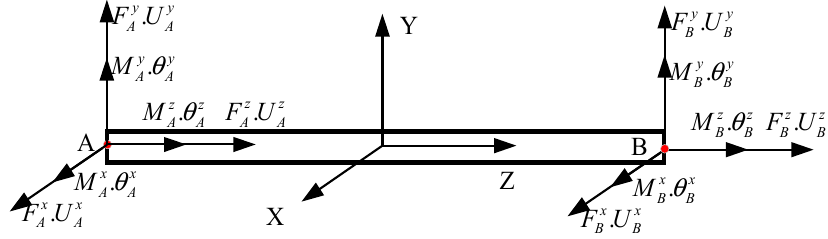
Figure 1. Notation for forces/moments and displacements/rotations of a beam.